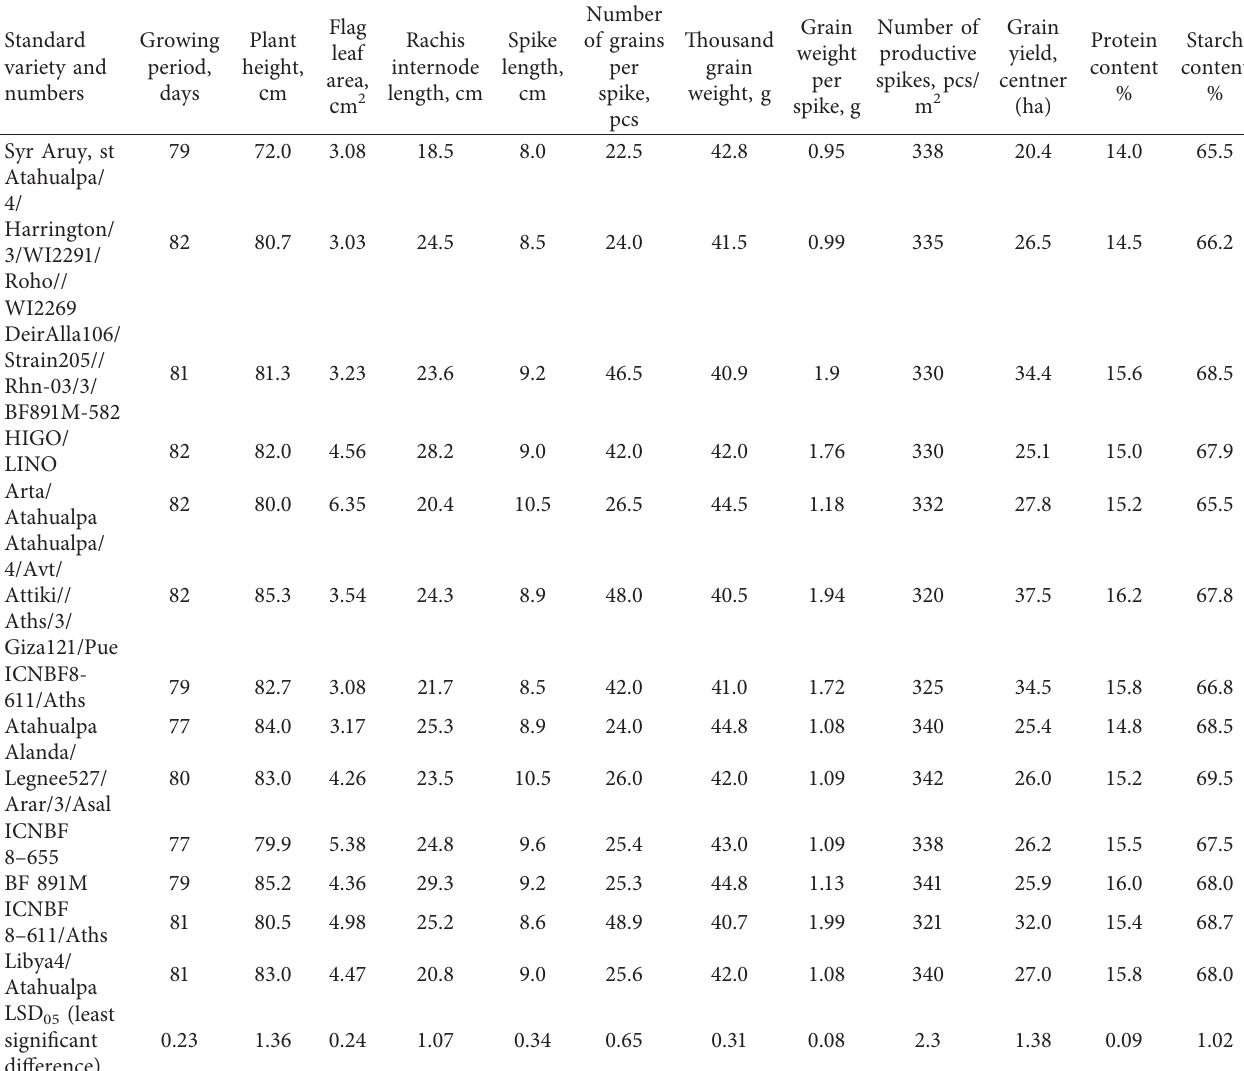
Table 4: Promising samples of hull-less barley for practical selection (average for